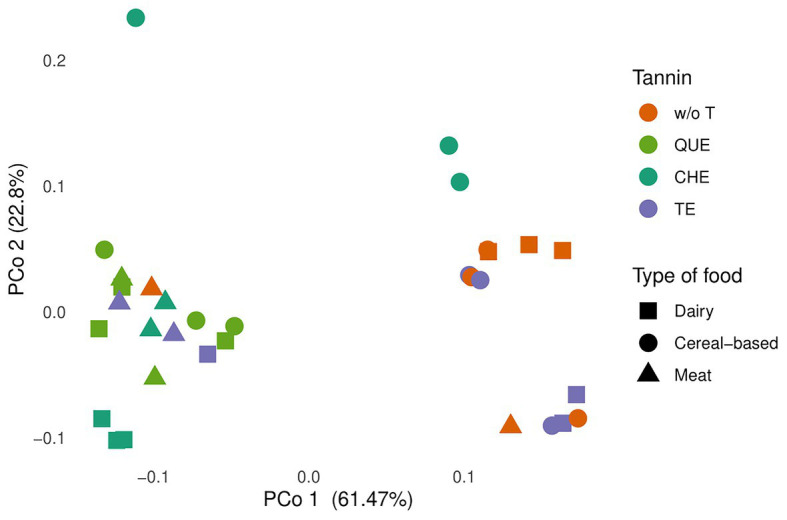
Principal coordinate analysis (PCoA) plot of total variation based on weighted UniFrac distances among microbial communities in all profiled samples, evaluated at genus level. The food sources were grouped in three food types: cereal-based foods (breakfast cereals, breakfast cereals with sugar, and bread), meat (meat and meat with 30% fat), and dairy products (milk, low fat yogurt, and full-fat Greek yogurt). w/o T, without tannins, QUE, quebracho tannins extract; CHE, chestnut tannins extract; TE, tara tannins extract.